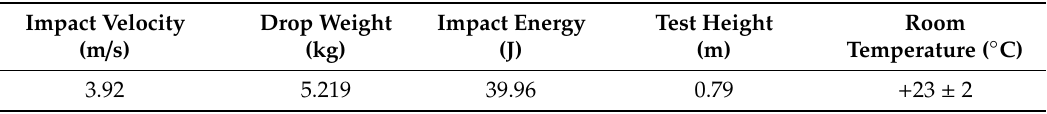
Table 4. Experimental conditions for the drop weight impact